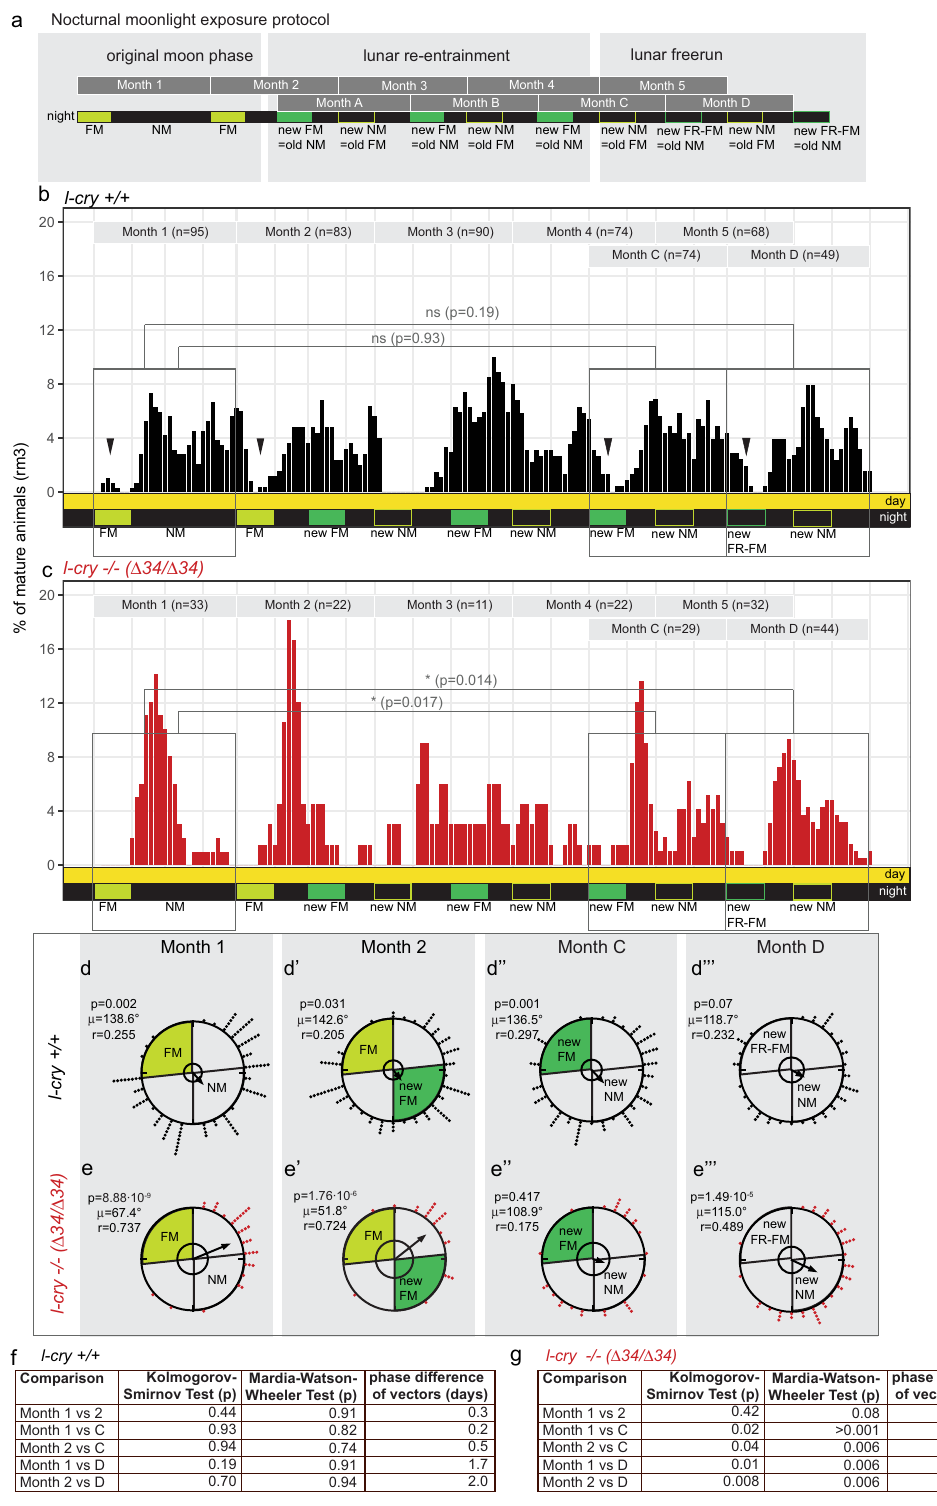
Fig.4| l-cry hasaminorcontributionasentrainingphotoreceptortocircalunar clock entrainment. a Nocturnal moonlight exposureprotocoloflunarphase shift with 8 nights of naturalistic moonlight (dark green). Number of mature animals (percentpermonth,rollingmeanwithawindowof3days)of l-cry wild-type( b )and mutant ( c ) animals. p -values: Kolomogorov – Smirnov tests. Black arrowheads indicatespawning-freeintervalsofthewildtype,whichshiftedtothepositionofthe new FM (under free-running conditions: FR-FM). d , e Data as in ( b , c ) plotted as